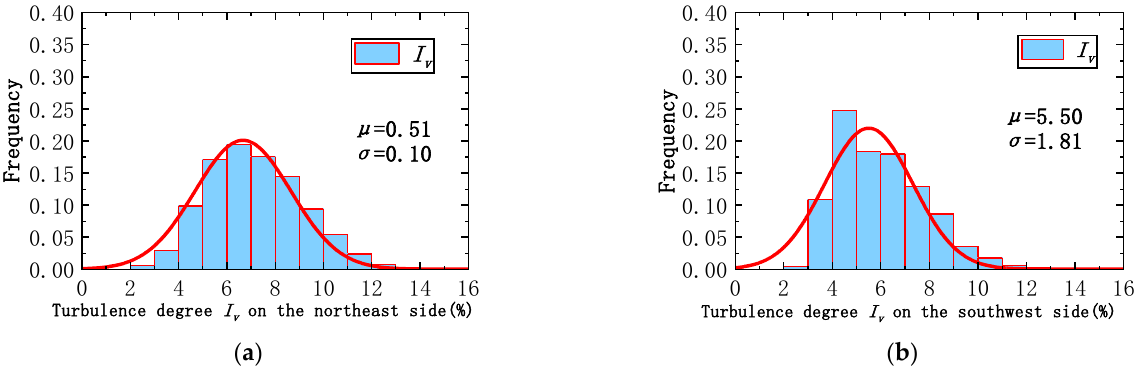
Figure 15. Probability statistics of crosswind turbulence I v : ( a ) turbulence degree I v on the northeast side; ( b ) turbulence degree I v on the southwest side.